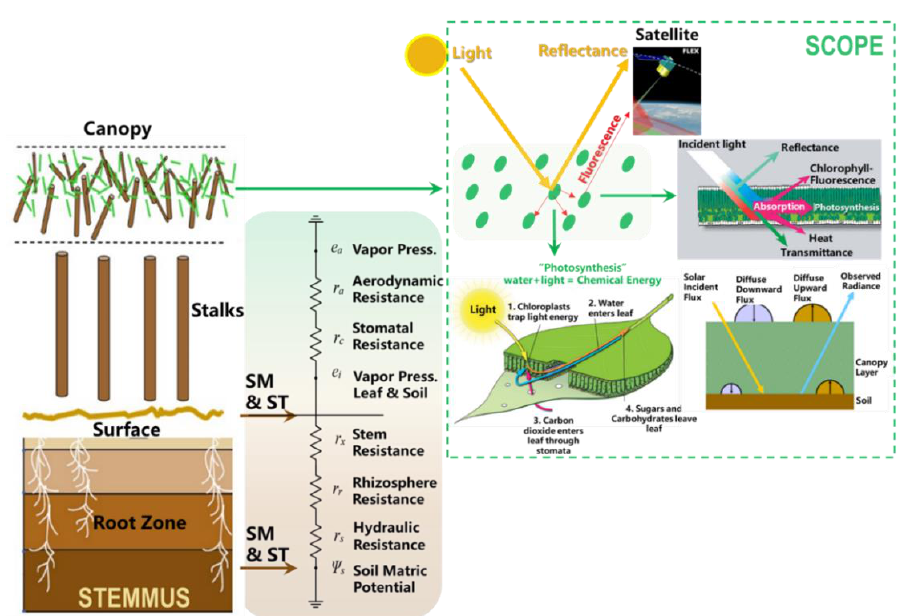
Figure 5. The main physical processes in the STEMMUS-SCOPE continuum model, integrating radiative transfer, vegetation photosynthesis, energy balance, root system dynamic, and soil moisture and soil temperature dynamic. The coupled model integrates vegetation photosynthesis and transfer of energy, mass, and momentum in the soil–vegetation system, via a simplified 1-D root growth model and a resistance scheme (from soil, through root zones and plants, to atmosphere) [80].